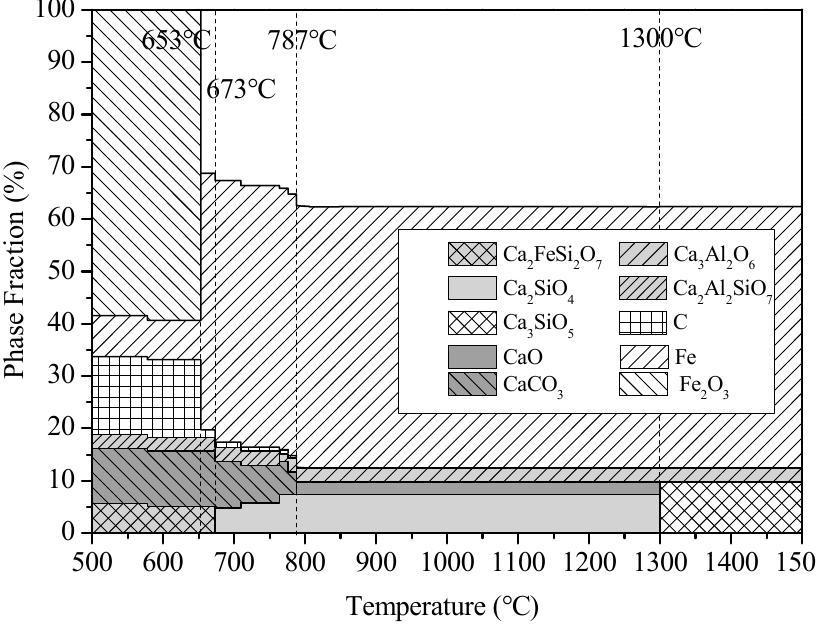
Figure 5. Variation diagram of the products of hematite reduction roasting.